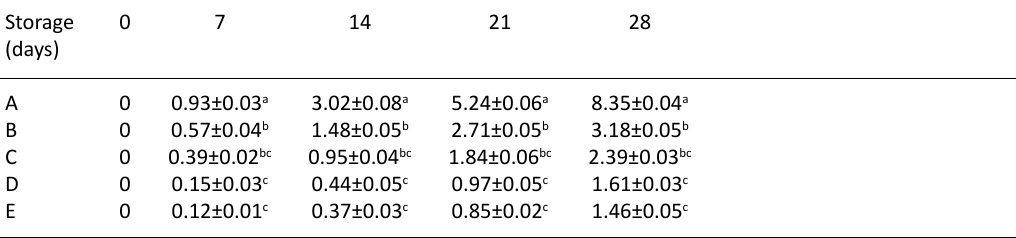
Table 1. Weight attrition (%) of mango fruit pre-coated by different MC-Car solutions during storage